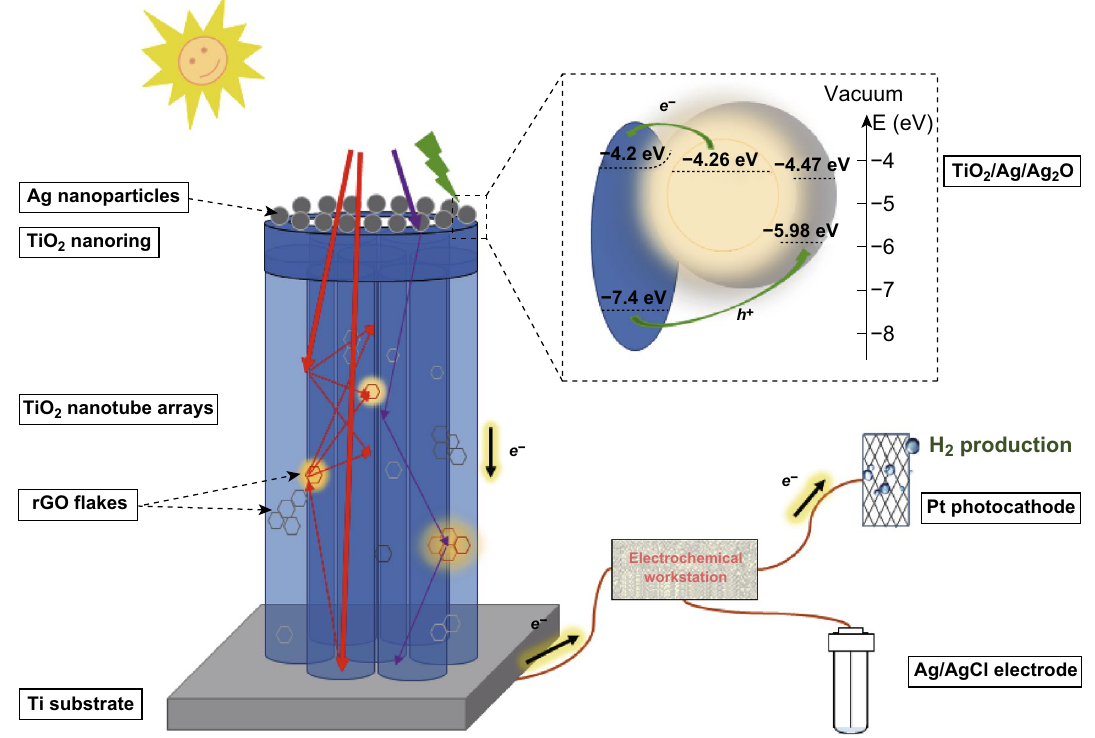
Fig. 11 Schematic illustration of the photoresponse and photogenerated charge transfer of Ag-TiO 2 R/T-rGO under UV–Vis light